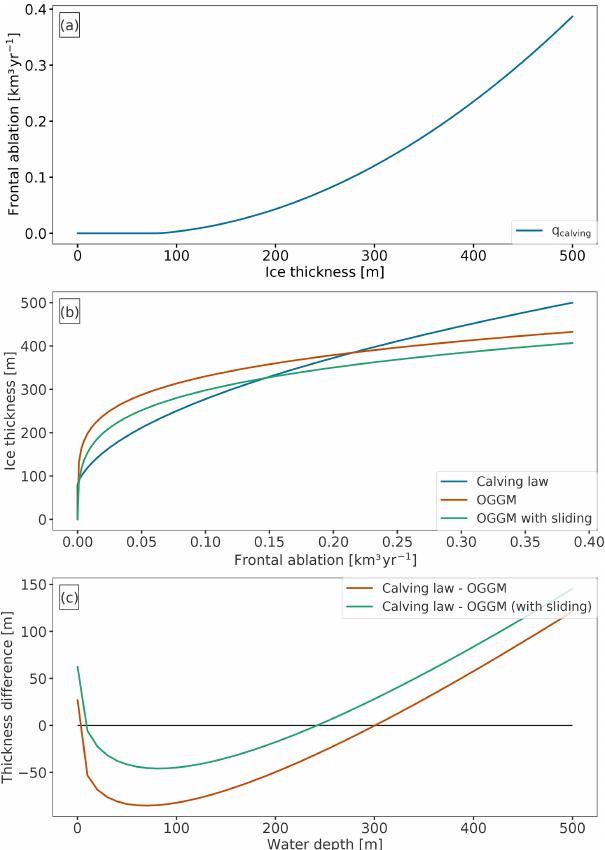
Figure 3. Idealized experiments applied to the LeConte Glacier. (a) Frontal ablation flux computed by the calving law when pre- scribing a terminus thickness, with h f ranging from 0 to 500m. (b) Terminus ice thickness per frontal ablation flux obtained (i) by the calving law (blue curve, same as a ), (ii) by OGGM using ice de- formation (orange curve), and (iii) by OGGM using ice deformation and adding a sliding velocity (green curve). (c) Illustration of the ice thickness function from Eq. (10) for a given range of water depth values: (i) without a sliding velocity (orange curve) and (ii) with a sliding velocity (green